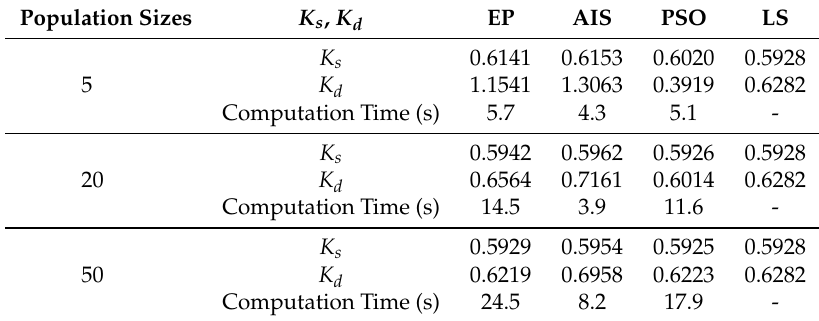
Table 2. Results of K s , K D and computation time for three different population sizes with P = 0.6 p.u. and Q = 0.7